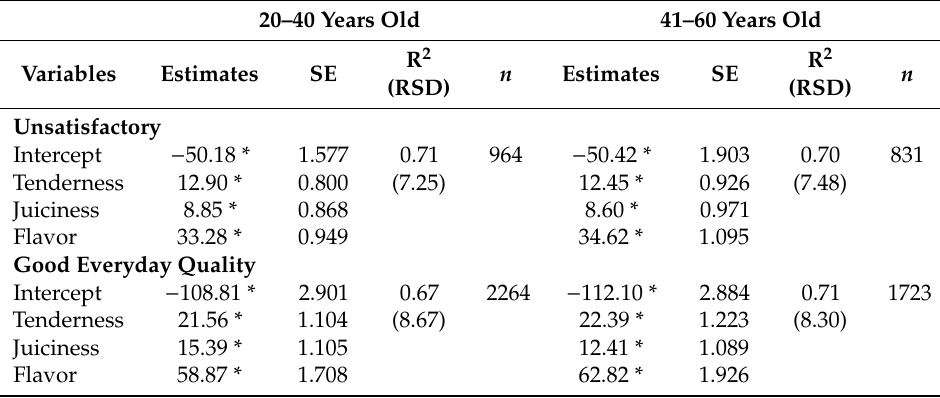
Table 10. Comparison of attribute intensity for age groups by satisfaction